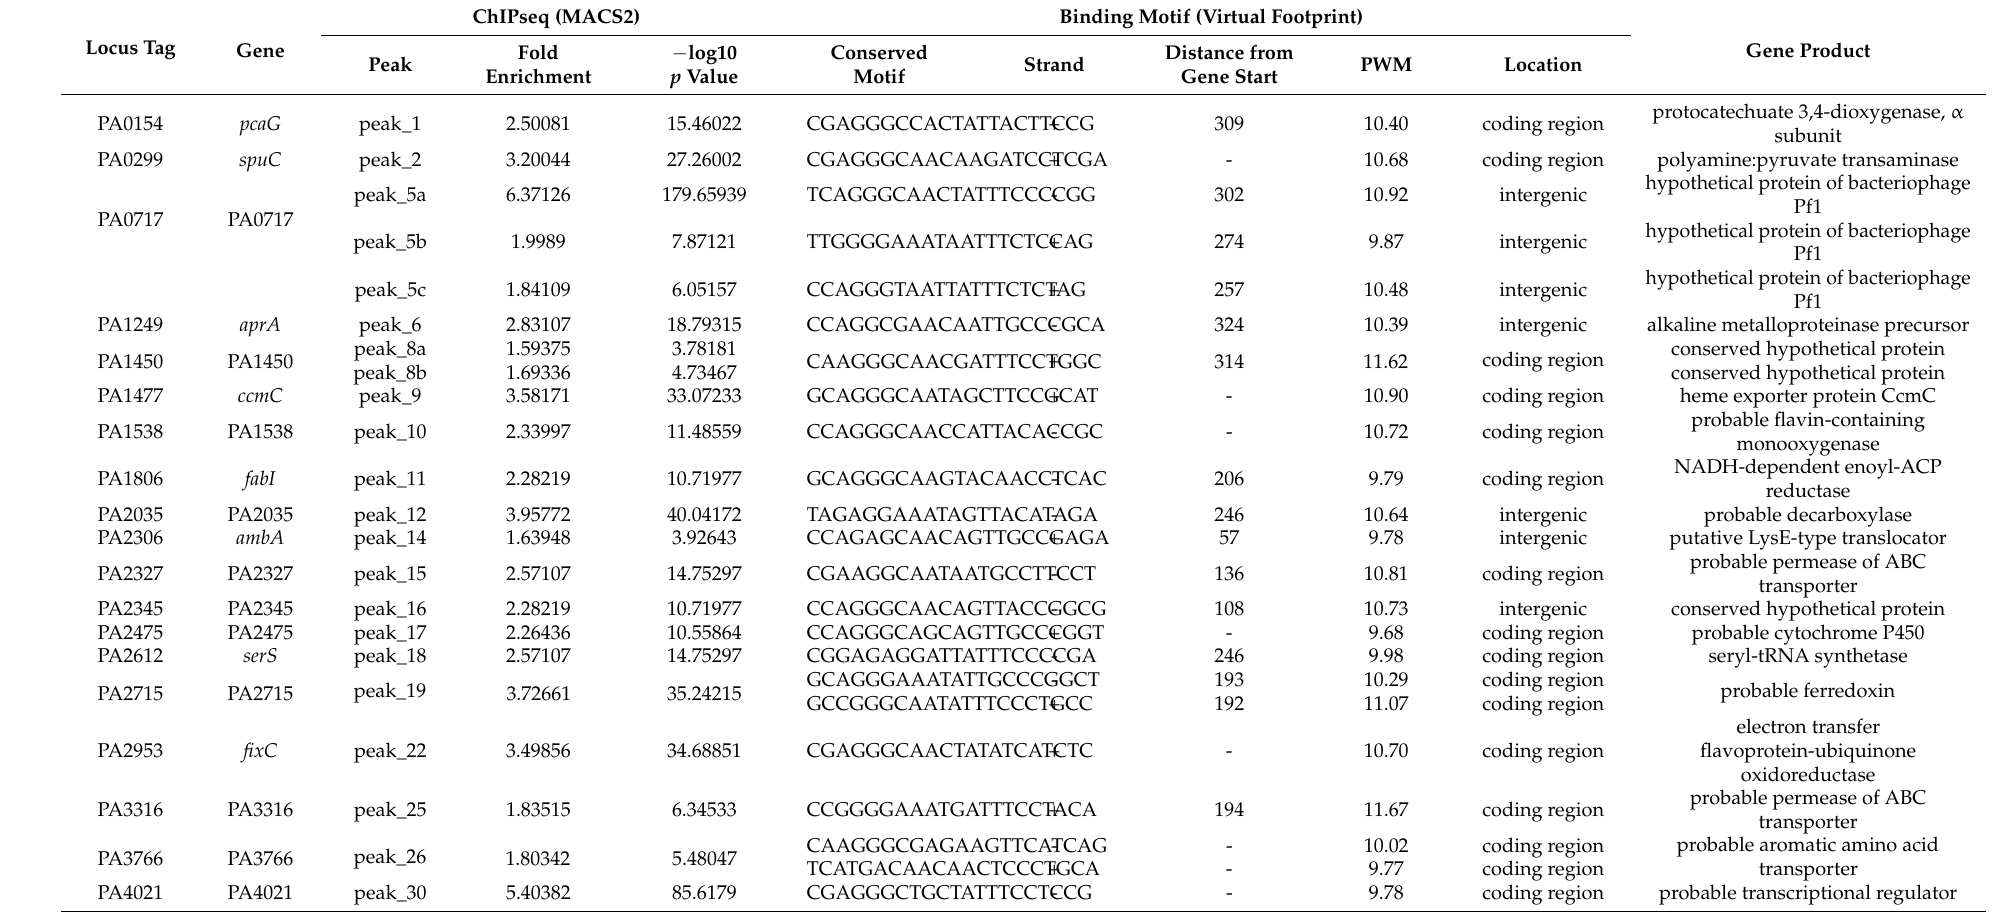
Table 1. Consensus ChIPseq peaks detected and predicted gene targets of the